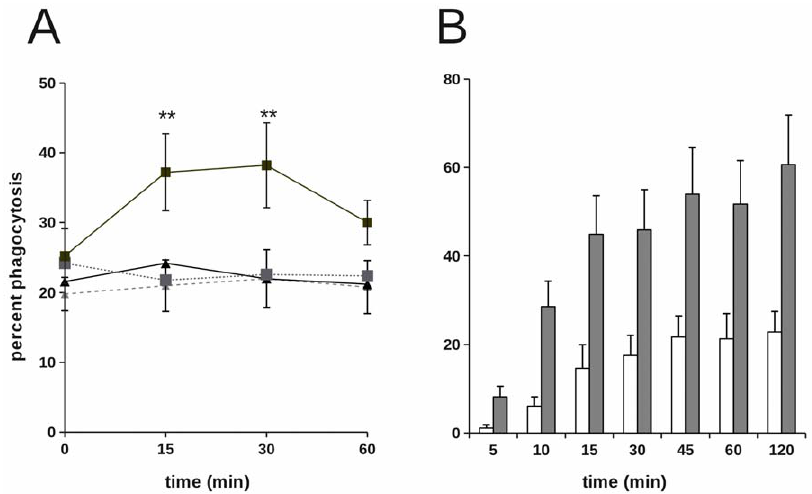
Figure 1. CD44 cross-linking promotes human macrophage phagocytosis of apoptotic human PMN. A) Monocyte-derived macrophages were incubated with CD44 mAb 5A4 Fab 9 fragments (squares) or control Fab 9 (triangles) for 30 min prior to addition of F(ab 9 ) 2 goat anti-mouse immunoglobulins (black symbols, solid line) or PBS control (gray symbols, dashed lines). Macrophages were then co-incubated with apoptotic targets at 37 u C for the times indicated prior to assessment of phagocytosis by microscopy. Results shown are mean 6 SEM for n=5 separate experiments. ** indicates significant difference between cross-linking versus non-cross-linked (p , 0.01). B) Monocyte-derived macrophages were incubated with CD44 mAb for 30 min to allow saturation of binding prior to addition of CMFDA-labelled apoptotic targets at 37 u C for the times indicated. Assessment of phagocytosis was made by flow cytometry (white bars=untreated; gray bars (CD44-treated). Data shown are mean percentage phagocytosis 6 SEM for 3 independent experiments. At all time points examined except 5 min, CD44-treated cells exhibit significant augmentation of phagocytosis (p , 0.05).